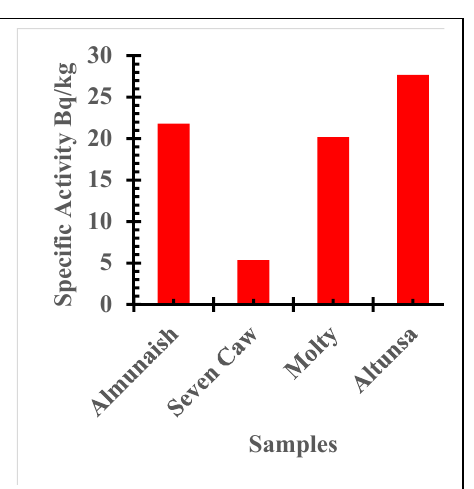
Fig. 2: The specific activity for 232 Th in all